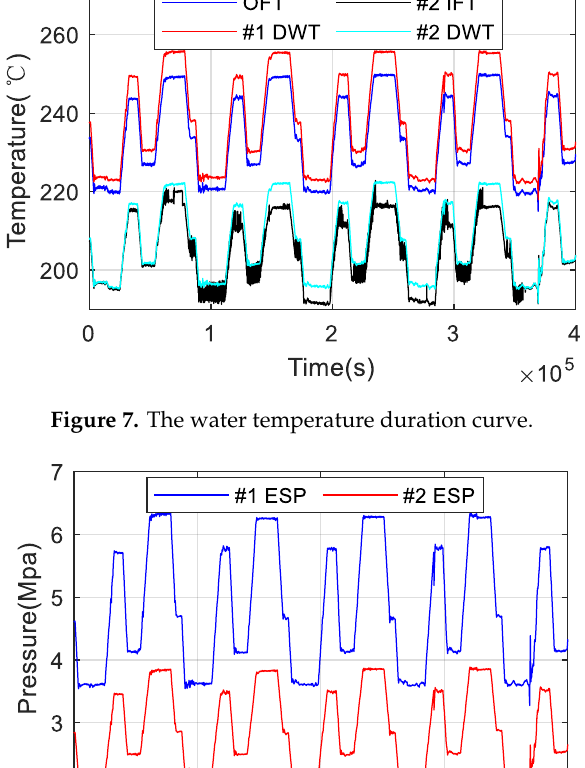
Figure 9. The #2 EST temperature duration curve. In traditional research, any relevant parameters can be used as input features for modeling. But from the perspective of information theory, if all the parameters are taken as the model input, though more information can be obtained, more noises are introduced simultaneously. Furthermore, if too many parameters are used as model input features, too much duplicate information will be introduced, which is called redundant information in this paper. A fair amount of redundant information will bring a negative impact on fault early warning performance and conceal the fault weak